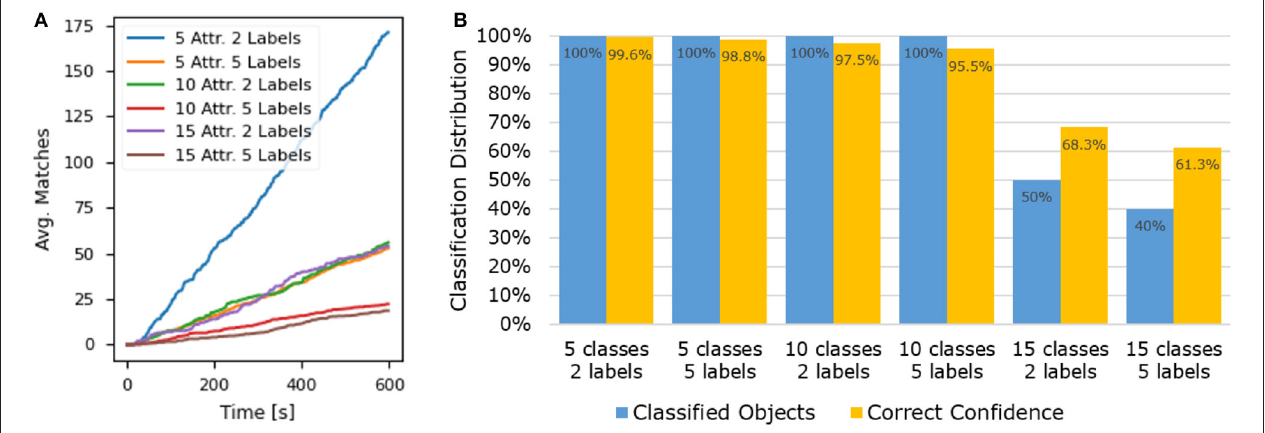
FIGURE 5 | Results from the framework evaluation experiments. (A) Presents the average number of matches per validation label over time, with respect to the number of attribute classes and the number of submitted validation labels. (B) Presents the classification distribution and confidence for the evaluated test cases with varying numbers of attribute classes and unknown validation labels. A label was considered classified if it reached 5 or more player matches, a confidence exceeding 70%, and the assigned crowd attribute was correct. The correct confidence was computed as the ratio between the correct and total number of